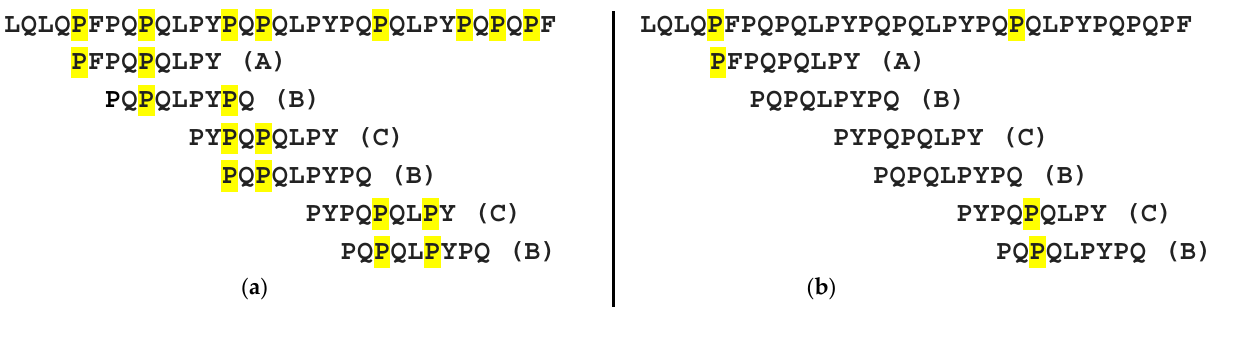
Figure 4. CD-active peptide QPFPQPQQPIPQ from secalin. Cleavage sites of the FvpP (upper line) and An-Pep (bottom line) are marked in yellow. No cleavage sites within the peptide were detected in any of the secalins identified in the An-Pep samples.